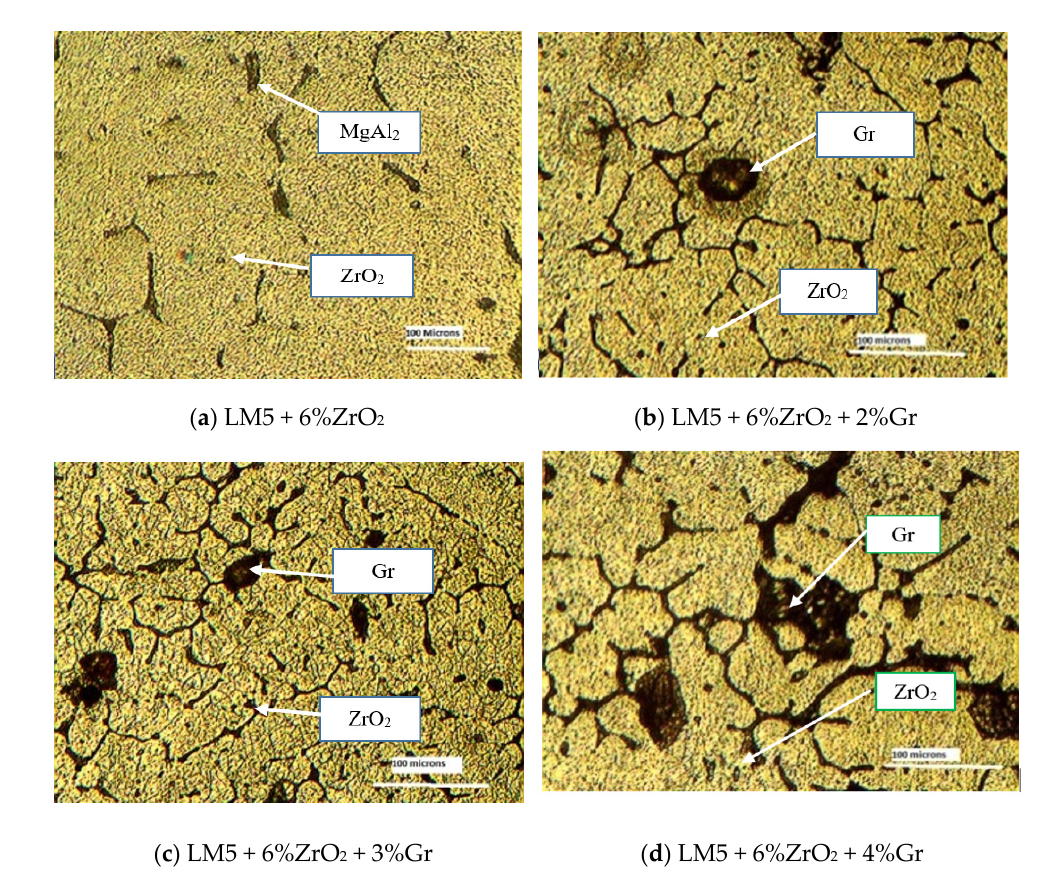
Figure 5. Micrographs of hybrid composites.